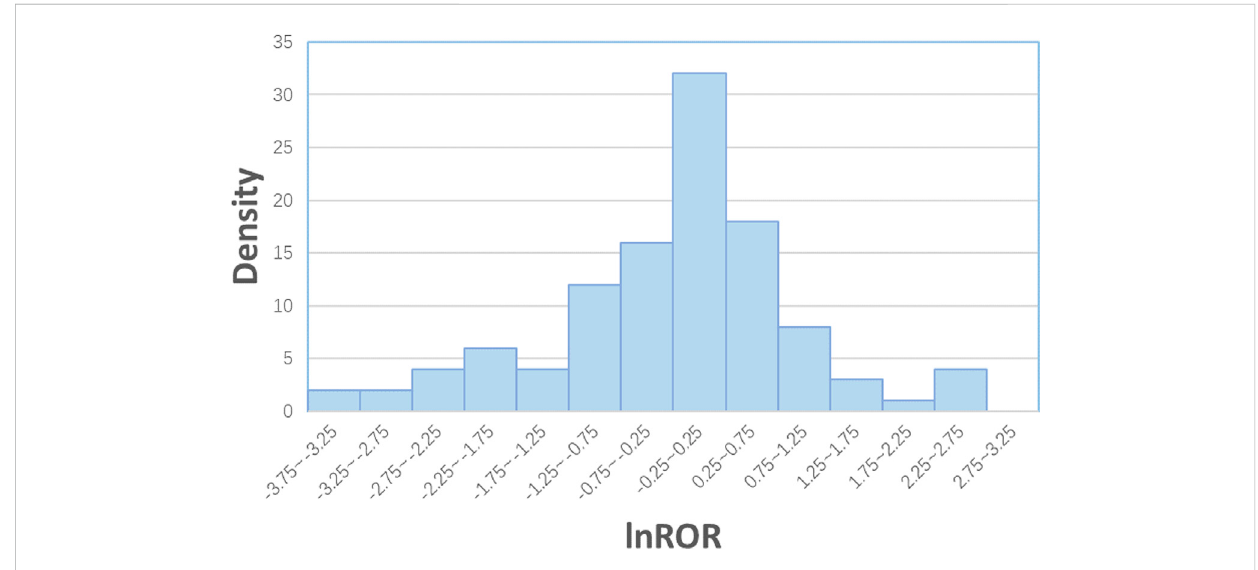
FIGURE 1 Distribution of